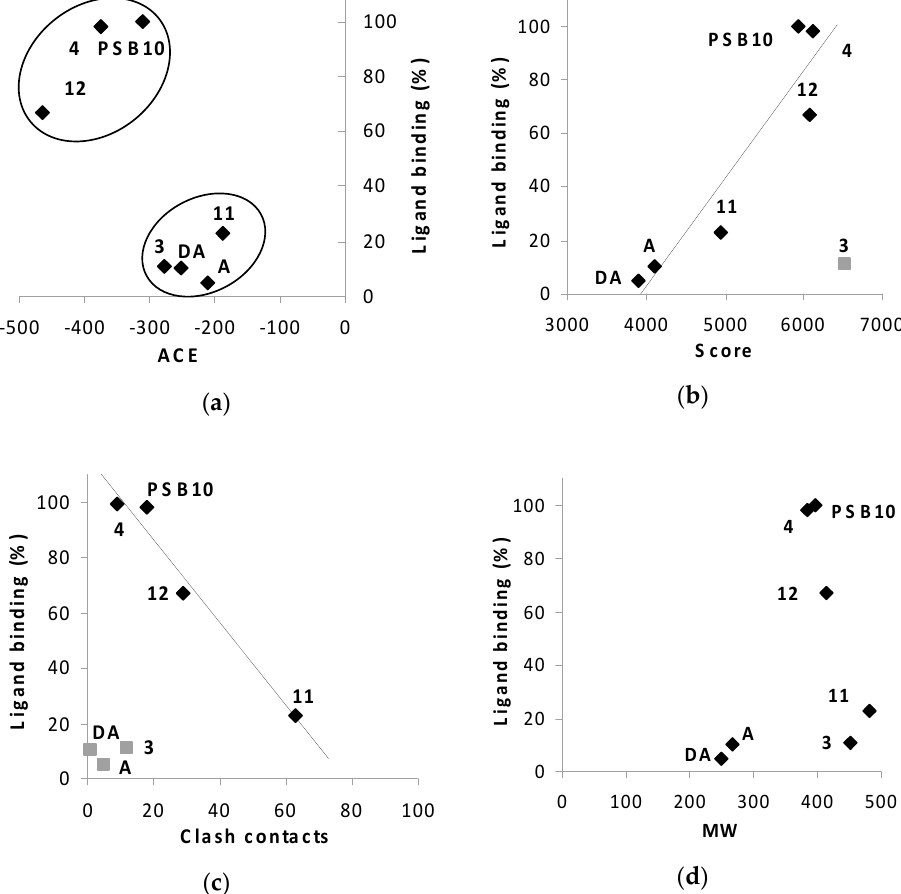
Figure 12. Relationships of desolvation energy, ACE ( a ), geometric scores ( b ) and clash contacts ( c ), calculated in silico, and ligand binding in vitro for A3 receptor, for the compounds 3 , 4 , 11 , 12 , PSB 10, adenosine (A) and 2 ′ -deoxyadenosine (DA) as ligands; The relationship of ligand binding and molecular weight (MW) ( d ). Ligand binding was determined in radioligand competition binding assay as described in Materials and Methods, and expressed as % inhibition of a specific binding at 10 µM. Values of MW [D] for 3 , 4 , 11 , 12 , PSB 10, adenosine and 2 ′ -deoxyadenosine are 451.53, 385.42, 481.56, 415.44, 398.67, 267.24 and 251.24,